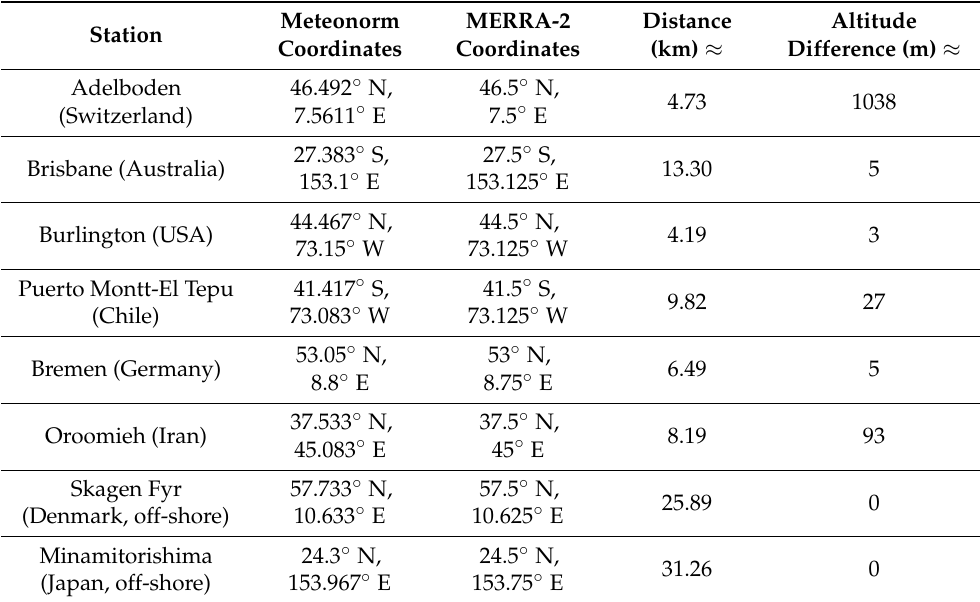
Table 2. Chosen Meteonorm stations vs. their corresponding MERRA-2 datapoints.